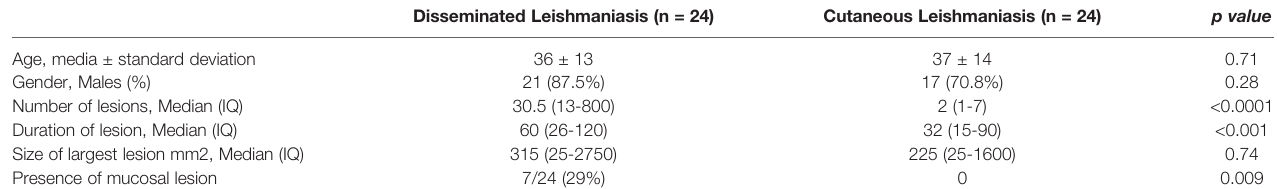
TABLE 1 | Clinical and epidemiological characteristics of patients with disseminated leishmaniasis (DL) and cutaneous leishmaniasis (CL).